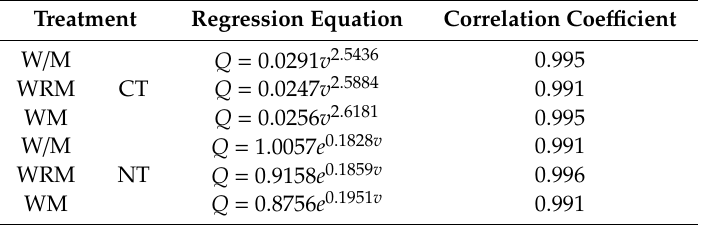
Table 3. Relationship between wind-blown soil mass and wind speed as affected by cropping system in 2017 and 2018.